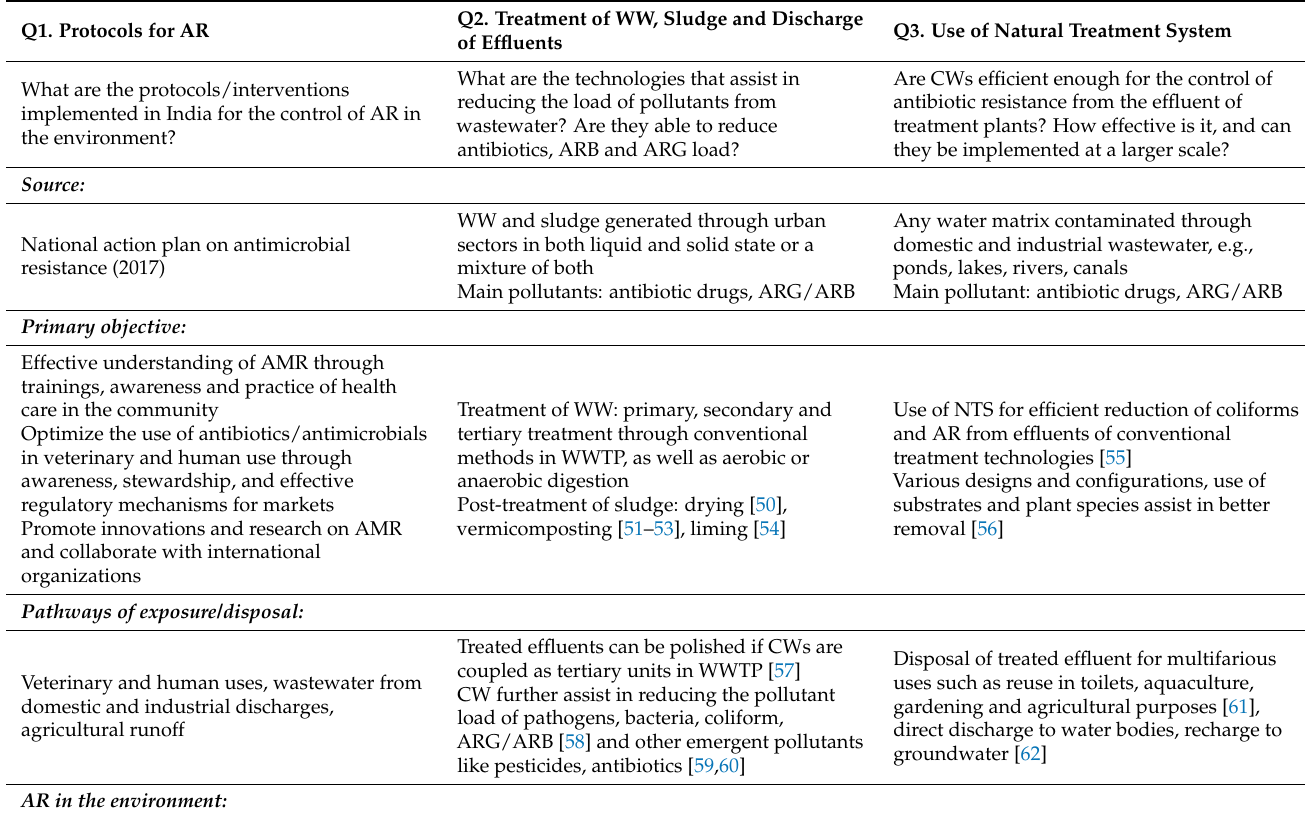
Table 1. Description of the question of concern for the present review study related to antibiotic resistance in wastewater and the use of constructed wetlands in reducing the loads from treated